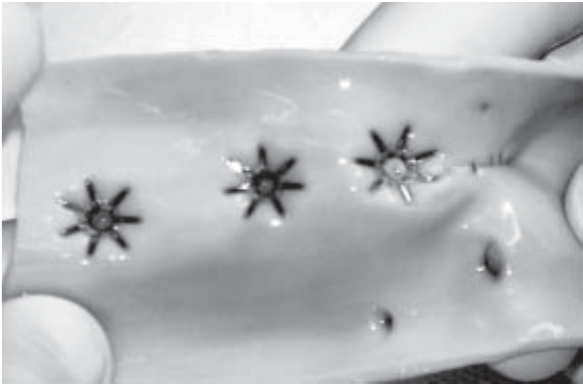
Fig. 8 – Internal view of the pig’s aorta where several mechanical suture devices can be